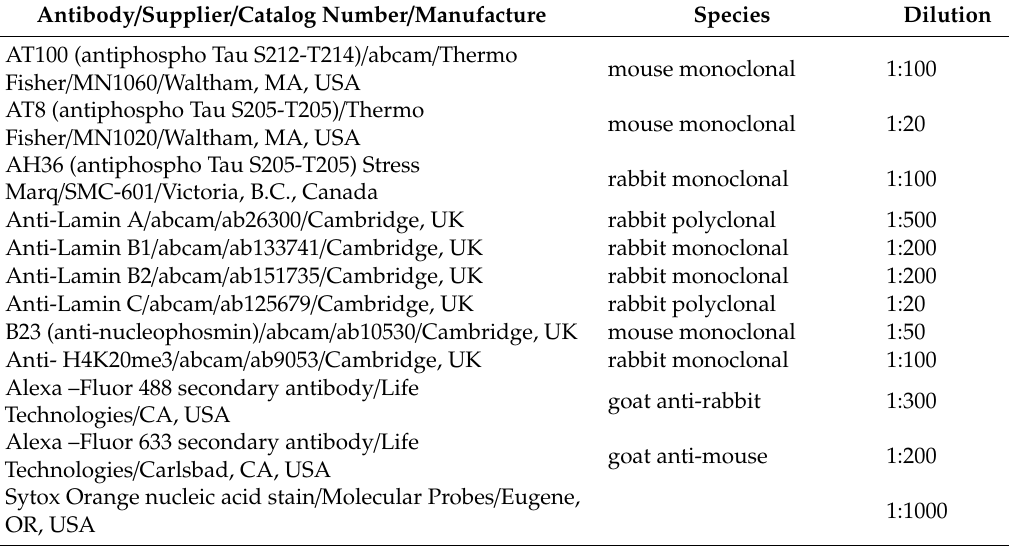
Table 1. Details of the employed